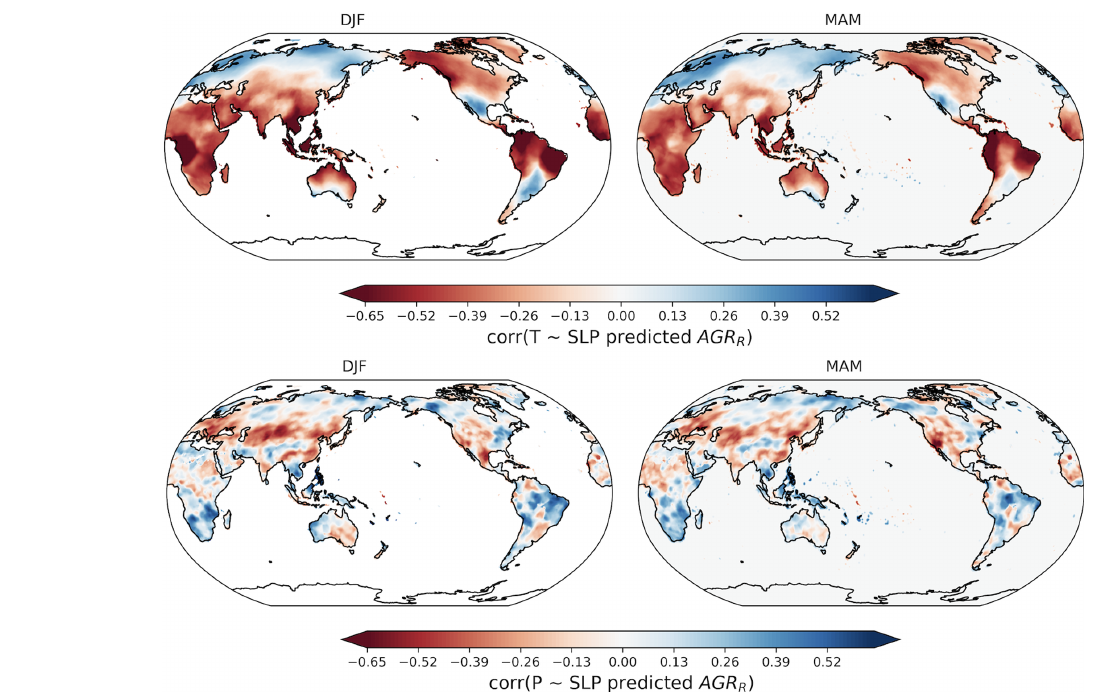
Figure A11. The spatial distribution of Pearson correlations between global SLP-predicted AGR R (one time series) and global pixel-based land temperature and precipitation anomalies (both from the CRU TS4.05 Harris et al., 2020, monthly dataset, aggregated to annual mean temperature and annual sum precipitation, detrended by LOWESS) in the period 1980–2017. The top panel shows the spatial distribution of Pearson correlations between pixel-based land temperature anomalies and global SLP-predicted AGR R for DJF (left) and MAM (right), and the bottom panel shows Pearson correlations of land precipitation